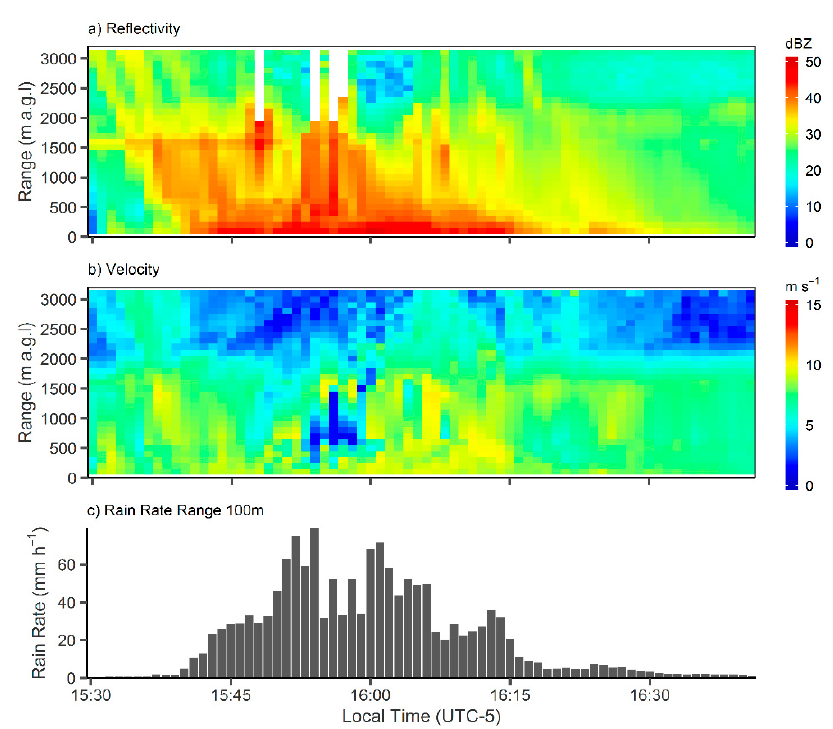
Figure 6. Event without bright band on 29 January 2019: ( a ) reflectivity profile (dBZ), ( b ) vertical fall velocity (m s − 1 ), ( c ) rain rate at range of 100 m a.g.l (mm h − 1 ). White color in ( a ), represents missing data.